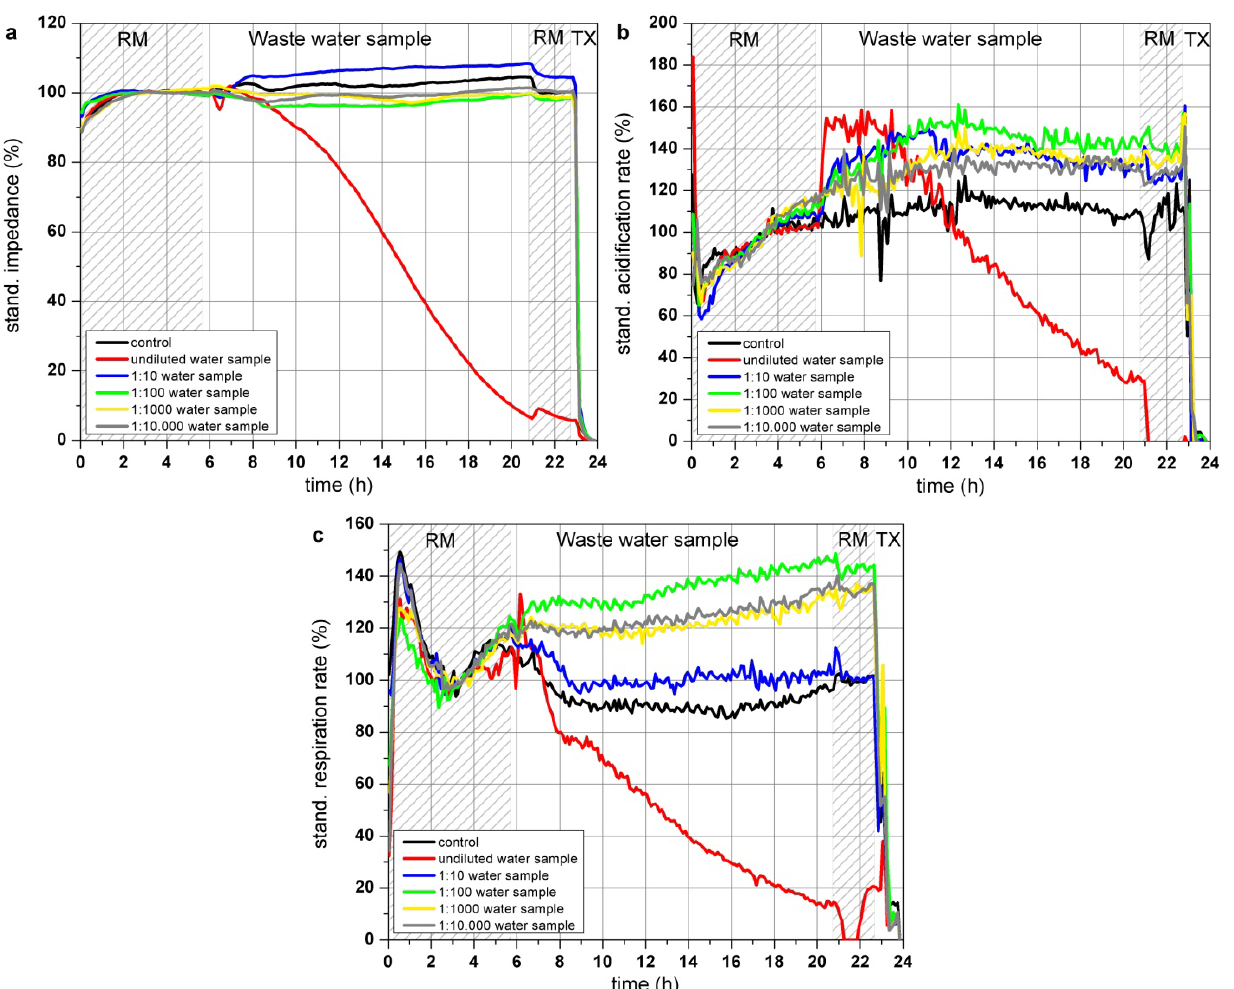
Figure 8. Time course of the impedance ( a ), acidification ( b ) and respiration ( c ) of L6 rat skeletal muscle cells during 24 h incubation with a real waste water sample in the Bionas 2500 Analyzing System. Vehicle control (black), undiluted (red), 1:10 (blue), 1:100 (green), 1:1,000 (yellow) and 1:100,000 (grey). Phases with running medium (RM) represent culture medium treatment without added